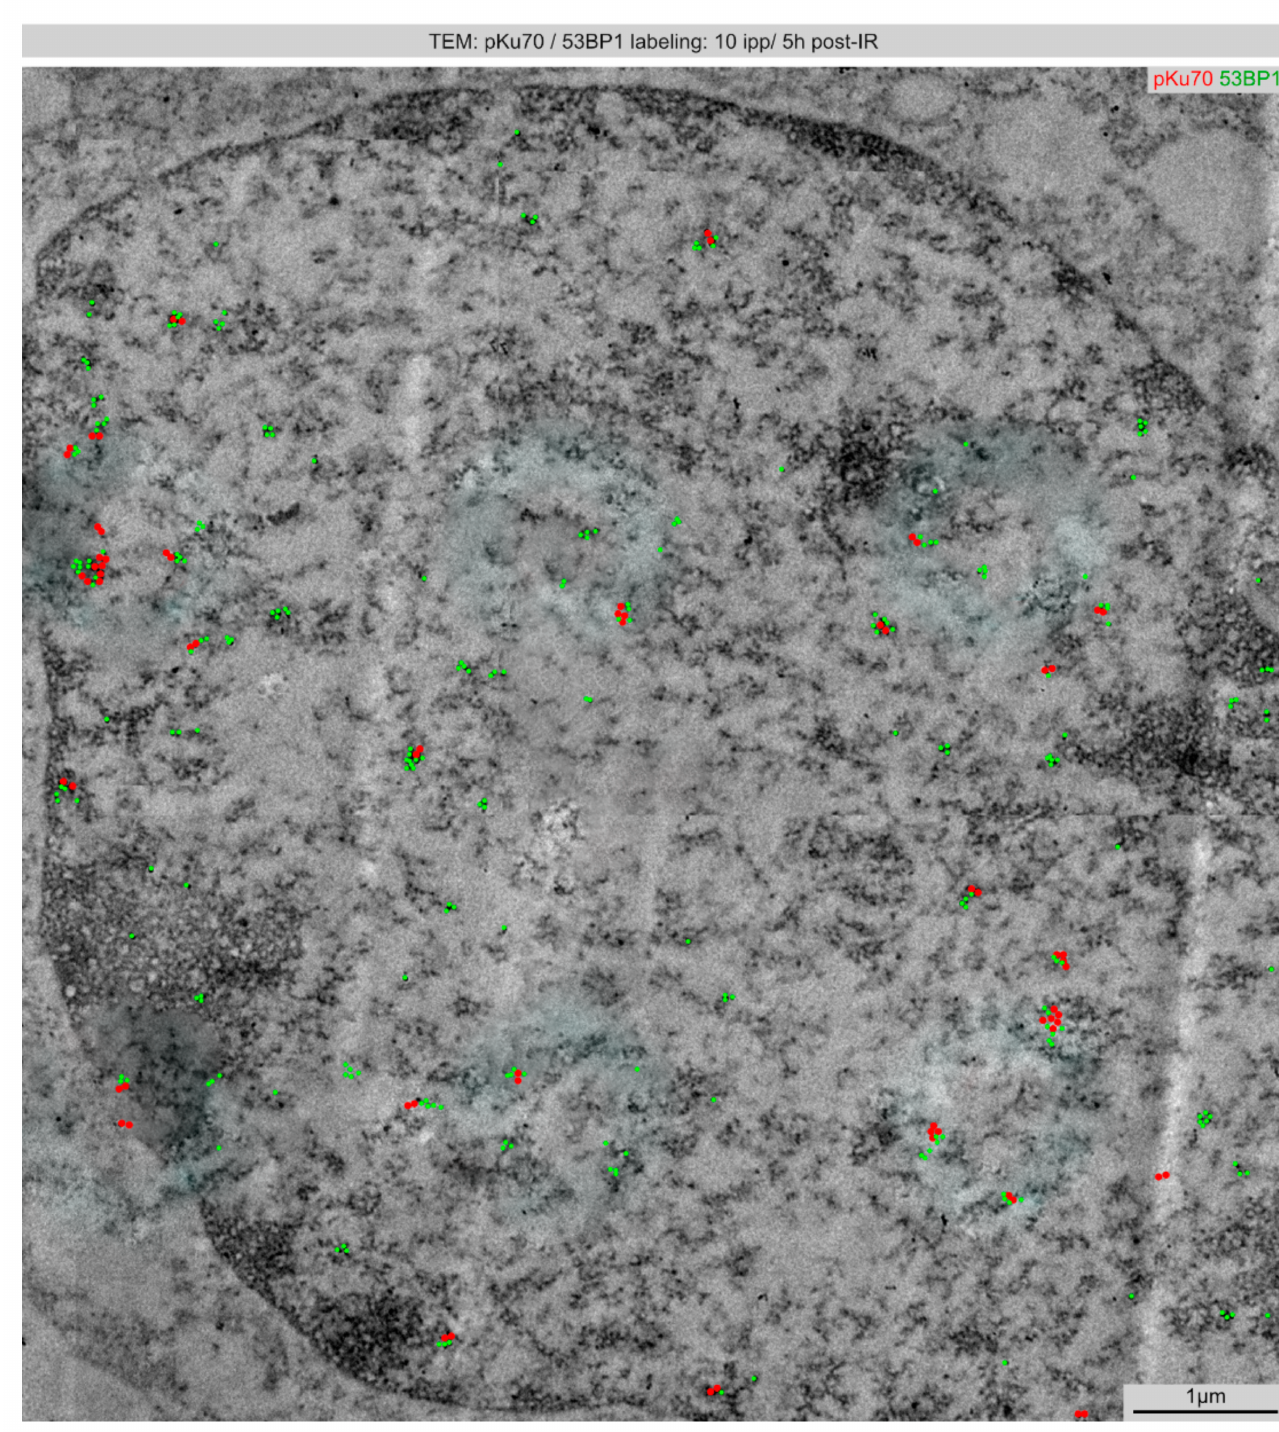
Figure 4. Spatial distribution of DNA lesions induced by multiple carbon ions (10 ipp) visualized by TEM. Micrograph of double-labeling for pKu70 (10 nm beads, colored in red) and 53BP1 (6 nm beads, colored in green) 5 h after focused microbeam IR with 10 ipp carbon